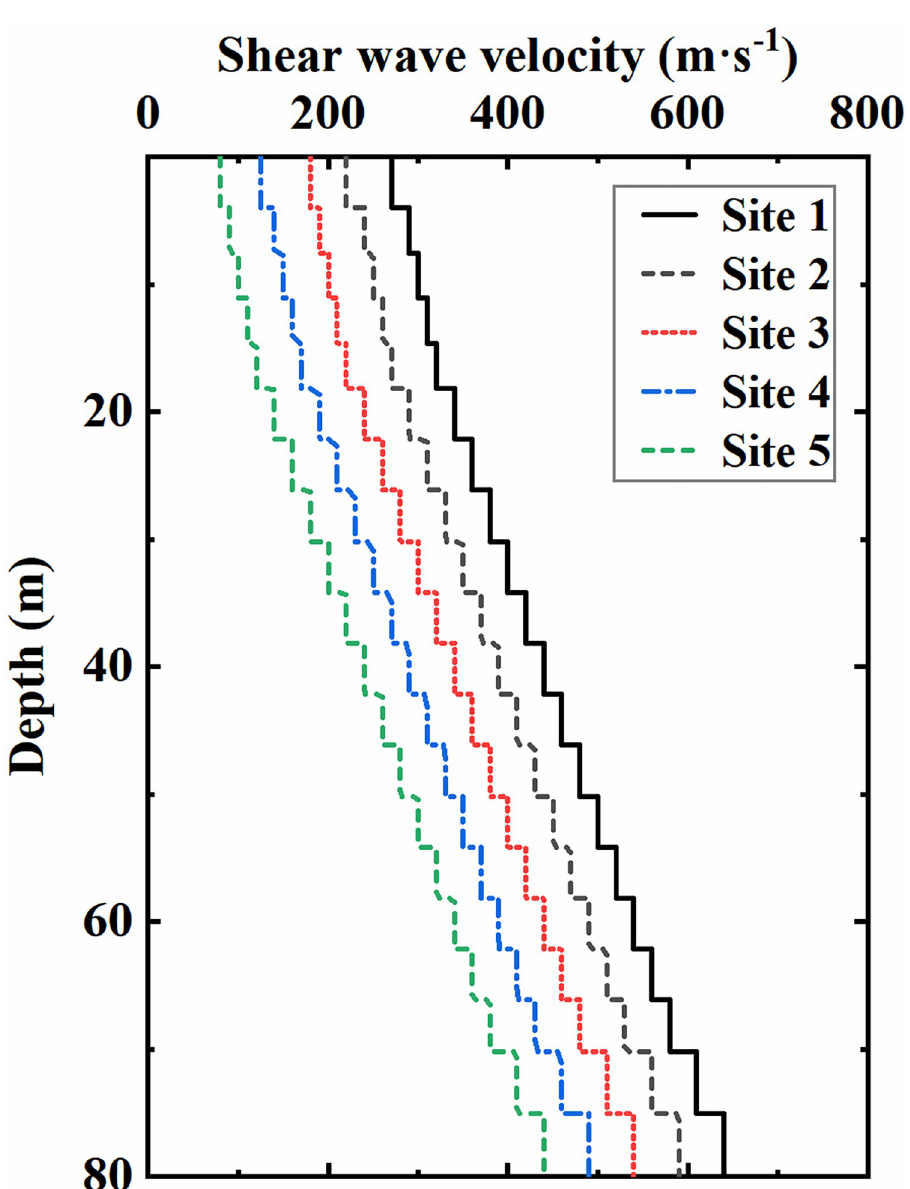
Fig 10. Variation in shear wave velocity with the soil